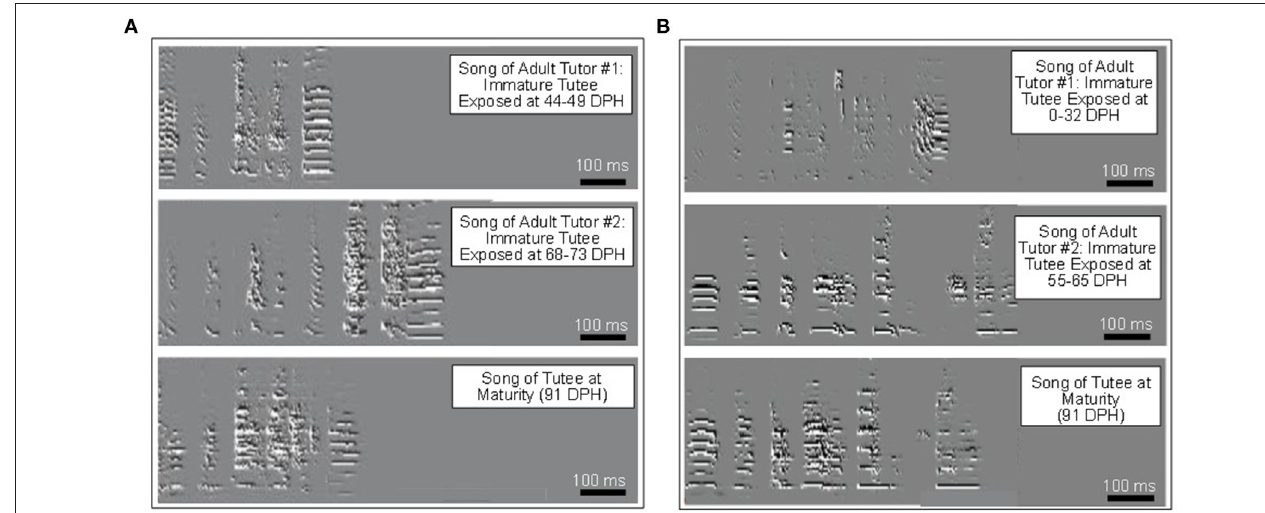
FIGURE 6 | Sonograms reflecting song learning and the influence of critical windows (sensitive periods) in the zebra finch, Taeniopygia guttata . By exposing developing birds (the tutee, or “student”) to adult song tutors during different periods of the tutee development, the critical window for song acquisition can be identified. In (A) , there was an 86% resemblance to Tutor #1, but only a 57% resemblance to Tutor #2. In (B) , using a different pair of tutors and different tutee, there was a 64% resemblance to Tutor #1, but an 84% resemblance to Tutor #2. Collectively these and other data from such studies suggest that auditory memory forms primarily from 25 to 35 days, but that the critical window duration varies upon the interplay of songs from different tutors, particularly in the latter part of the critical window. For most immature zebrafish, the critical window “closes” after 65 days post-hatch (DPH) (modified from Gobes et al., 2019).